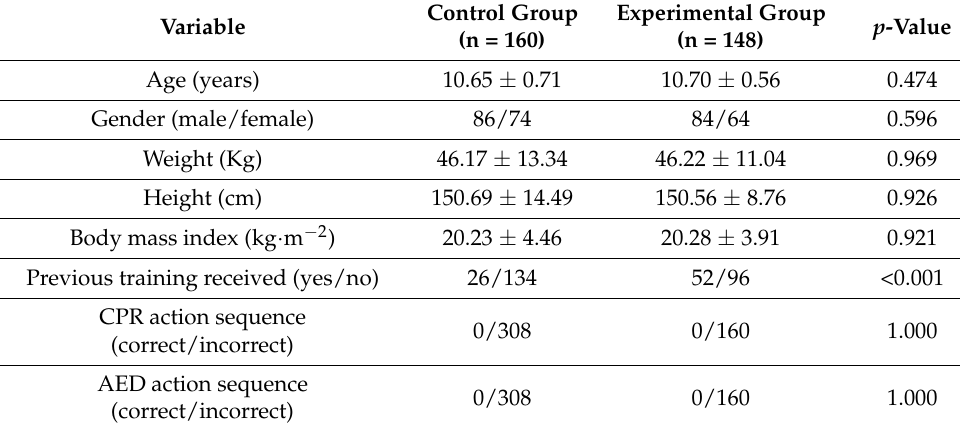
Table 1. Sample baseline characteristics.